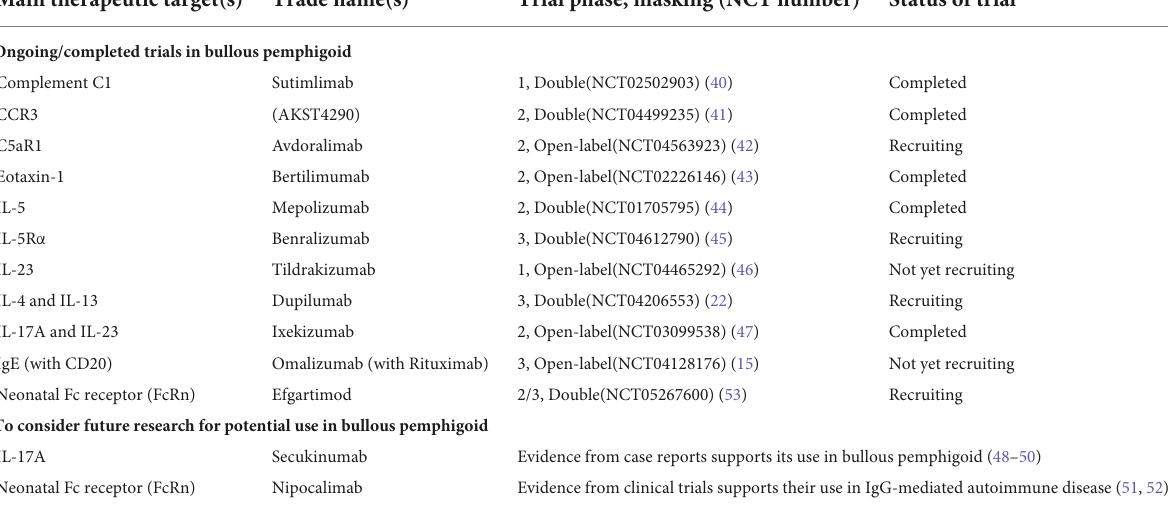
TABLE 1 Summary of ongoing/completed trials of novel pharmacologic agents in bullous pemphigoid and other promising agents for consideration (in alphabetical order). Main therapeutic